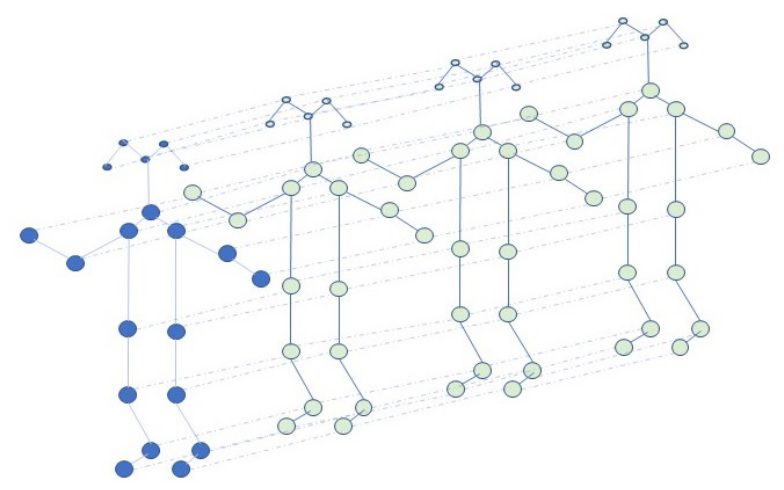
Figure 1. The keypoints denoted as blue dots in first frame and green dots in the following frames are used as input to the proposed graph convolutional neural network. The dots denote the body joints of the subject. The solid line shows the natural connection in intra-body. The dot line connects the inter-frame edges connects the same joints in consecutive